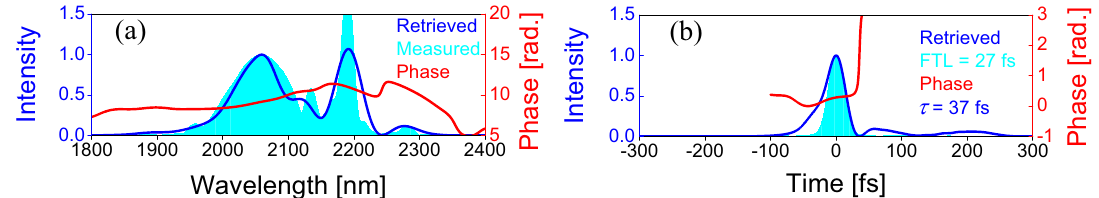
Fig. 1 SHG-FROG characterization of the KLM Tm,Ho:CALGO laser with a 0.2% OC. (a) Measured and retrieved optical spectrum and spectral phase; (b) retrieved intensity and phase and Fourier-transform-limited (FTL) pulse. The directly measured spectrum was centered at 2061.3 nm spanning from 1870 to 2337 nm, in reasonably good agreement with the one reconstructed from the SHG-FROG trace, see Fig. 1(a). After an external linear chirp compensation with a 5-mm thick ZnSe plate, the retrieved pulse had a duration (FWHM) of 37 fs (~5 optical cycles), still ~36% above the Fourier limit, see Fig. 1(b). The average output power amounted to 55 mW at an absorbed pump power of 2.85 W and a pulse repetition rate of ~76